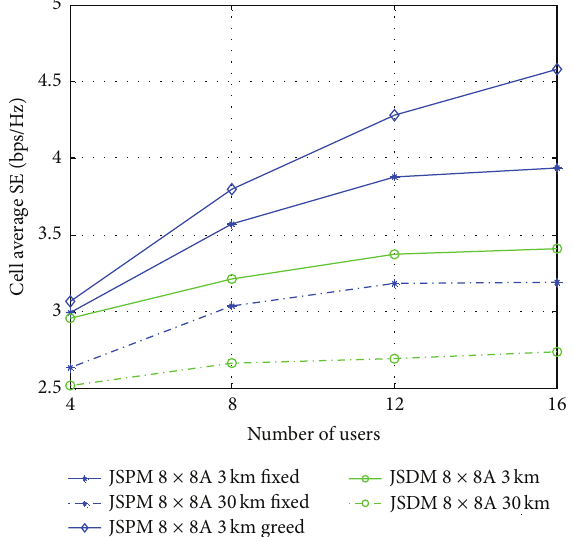
Figure 3: Comparison of sum spectrum efficiencies.